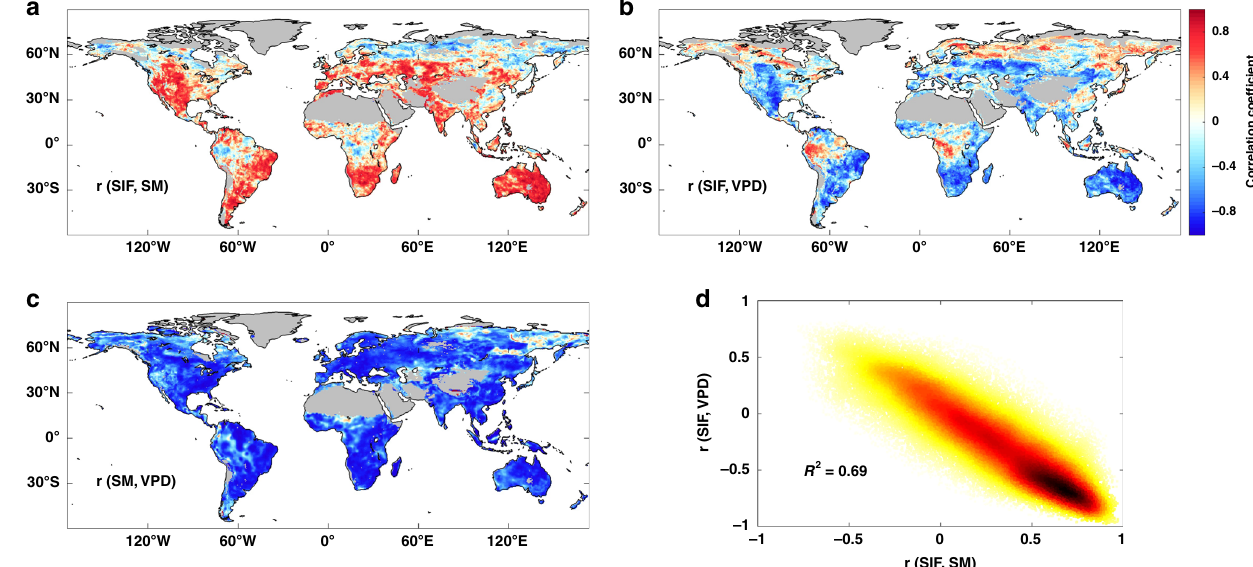
Fig. 1 Strong coupling of soil moisture and vapor pressure de fi cit confounds ecosystem dryness stress. a – c Spatial distribution of Pearson ’ s correlation coef fi cient between solar-induced chlorophyll fl uorescence (SIF) and soil moisture (SM) (r(SIF, SM)), SIF and vapor pressure de fi cit (VPD) (r(SIF, VPD)), and SM and VPD (r(SM, VPD)), at the yearly scale. Regions with sparse vegetation and regions without valid data are masked in gray. d Relationship between yearly r(SIF, VPD) and yearly r(SIF,SM) across land vegetated areas. Color shows the relative density of data points, with higher density in black and lower density in yellow.